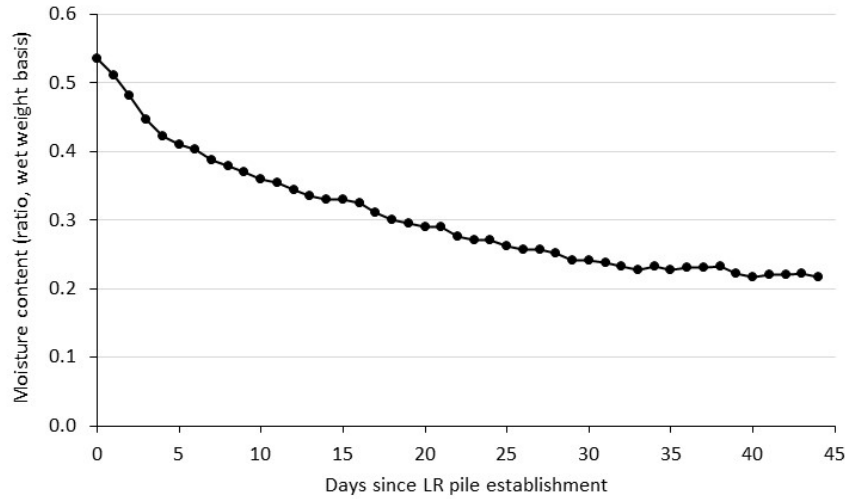
Figure 2. E. nitens (H.Deane & Maiden) Maiden LR drying model based on the model published in [39] with the rain response removed.